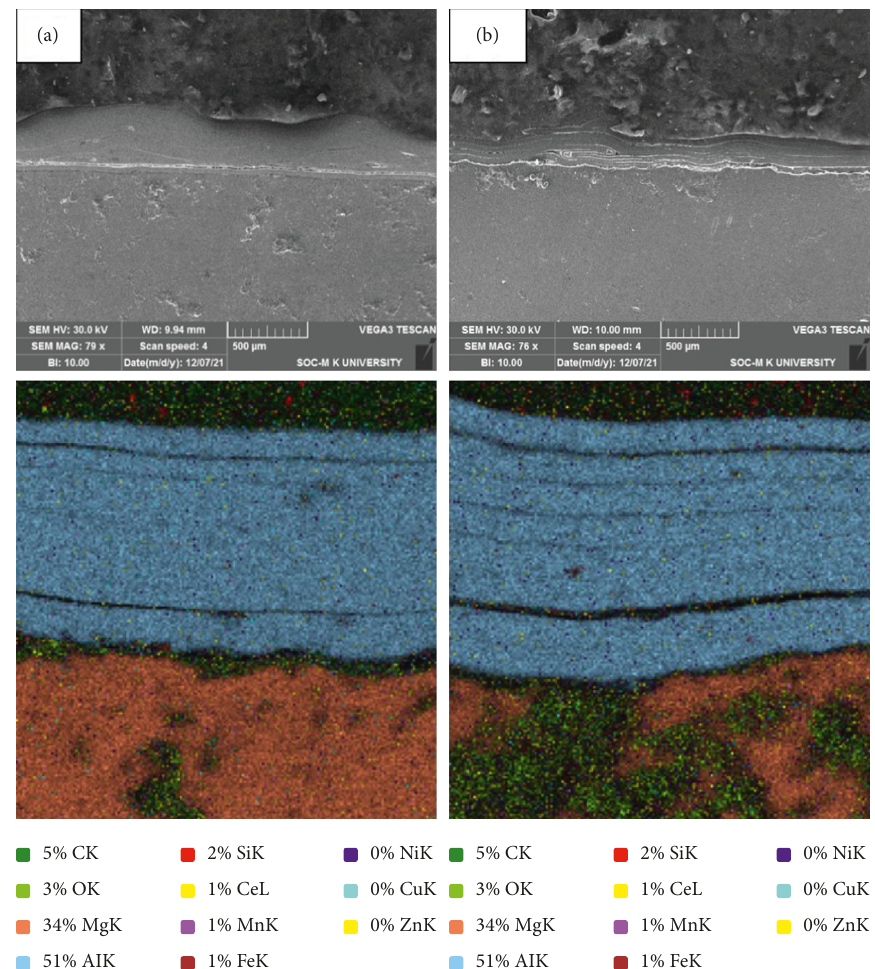
Figure 6: Cross-section micrograph for (a) Al powder coating and (b) epoxy coating on AZ91D+0.1wt.% Ce+0.1wt.% Li Mg